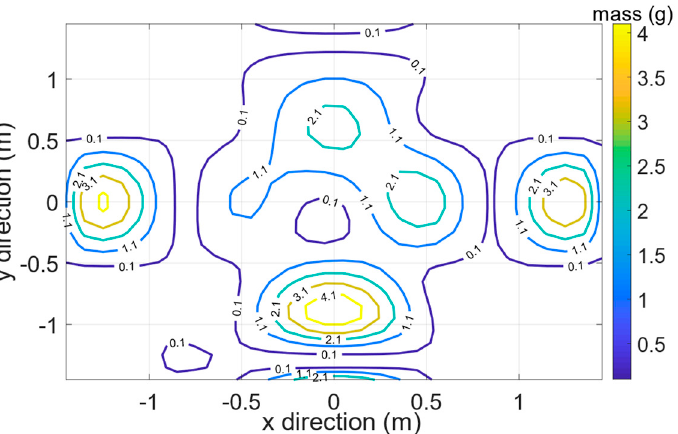
Figure 9. Contour map of firebrand mass distribution around the tree. The total inject number of firebrands is 5 × 70. Tree is mounted at (x, y) = 0, 0. The figure shows firebrand distribution is not uniform and more particles have landed in the negative y-direction.